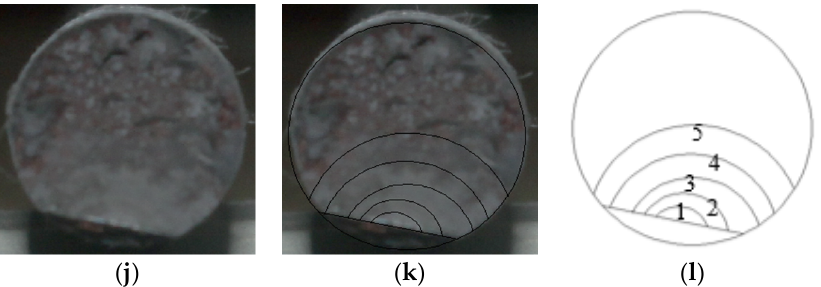
Figure 16. Steel wire sections with notches at di ff erent depths. ( a ) D-1 without “bench-like pattern” hooking; ( b ) D-1 with “bench-like pattern”; ( c ) schematic diagram of D-1 wire specimen; ( d ) D-2 without “bench-like pattern”; ( e ) D-2 with“bench-like pattern”; ( f ) schematic diagram of D-2 wire specimen; ( g ) D-3 without“bench-like pattern”; ( h ) D-3 with “bench-like pattern”; ( i ) schematic diagram of D-3 wire specimen; ( j ) D-4 without “bench-like pattern”; ( k ) D-4 with “bench-like pattern”; ( l ) schematic diagram of D-4 wire specimen.